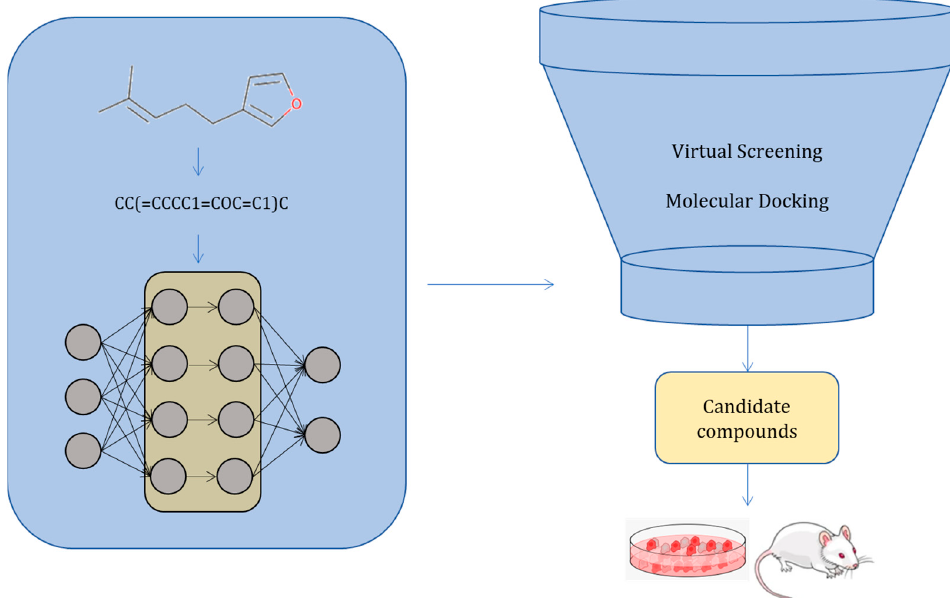
Figure 1. The workflow followed by most studies presented in this review. It contains molecules, molecular encoding, a deep architecture model, virtual screening, and/or molecular docking to reduce the number of candidate compounds to a final set of compounds. These are synthesized and tested for their activity in vitro and in vivo.